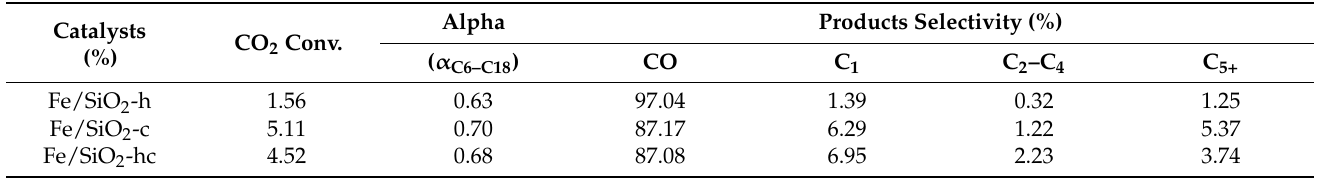
Table 4. Catalytic performances of the catalysts with different activated conditions in the CO 2 hydrogenation reaction conditions a